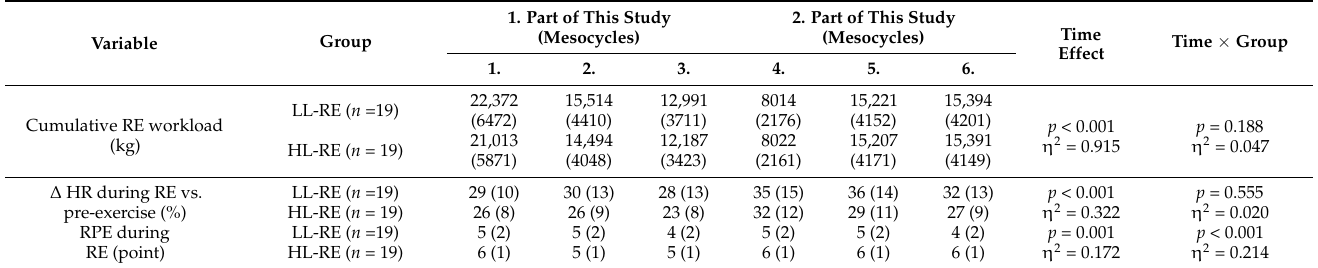
Table 4. Cumulative workload, heart rate and rating of perceived exertion during each mesocycle of resistance exercise training.